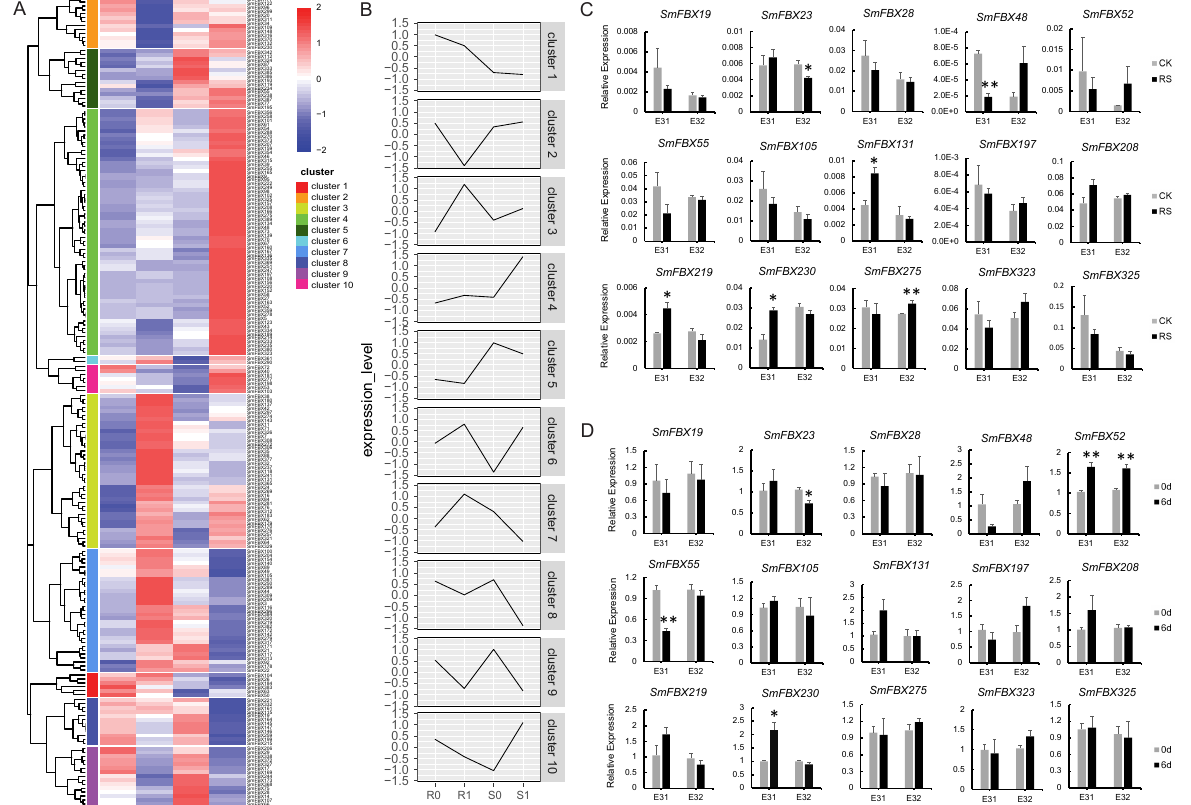
Figure 4. Transcriptome analysis of the F-box candidate gene superfamily in bacterial wilt resistant (E31, R) and susceptible (E32, S) eggplant varieties treated with Ralstonia solanacearum, followed by qRT-PCR verification. ( A ) F-box transcriptome heatmap analysis of E31 and E32 treated with R. solanacearum . R0 and S0 represent the disease-resistant and -susceptible eggplant varieties not inoculated with R. solanacearum, respectively. R1 and S1 represent the resistant and susceptible varieties after inoculation with R. solanacearum . Different clusters are marked with varying colors, and the left part of the figure indicates the phylogenetic analysis of the F-box candidate genes. ( B ) The F-box candidate genes were divided into 10 clusters, and the model of expression was obtained by counting the expression patterns of the genes in each cluster. ( C ) qRT-PCR validation of the screened F-box candidate genes. The expression analysis of the screened SmFBX candidate genes in each treated plant on the 6th day after R. solanacearum infection of E31 and E32 varieties. Samples were obtained, the RNA was extracted, and qRT-PCR was performed to verify the expression of the F-box candidate genes. CK, uninfected plants. RS, plants infected with R. solanacearum . ( D ) qRT-PCR validation of the screened F-box candidate genes after infection by R. solanacearum . The bacterial wilt-resistant variety E31 and the susceptible variety E32 were sampled after 0 and 6 days of infection by R. solanacearum. The RNA was extracted and qRT-PCR was performed to verify the expression of F-box candidate genes. The method of calculation was 2 − ∆∆ ct . qRT-PCR, real-time